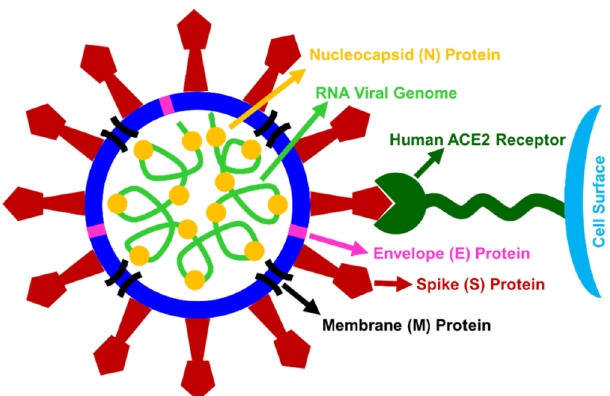
Figure 2. Hypothetical cartoon presentation of morphology, structural constituents, and possible receptor mediated cellular binding of SARS-CoV-2. Size, shape, and integral components are for visualization purpose only and do not exactly replicate the ultra-structural morphology of virus.